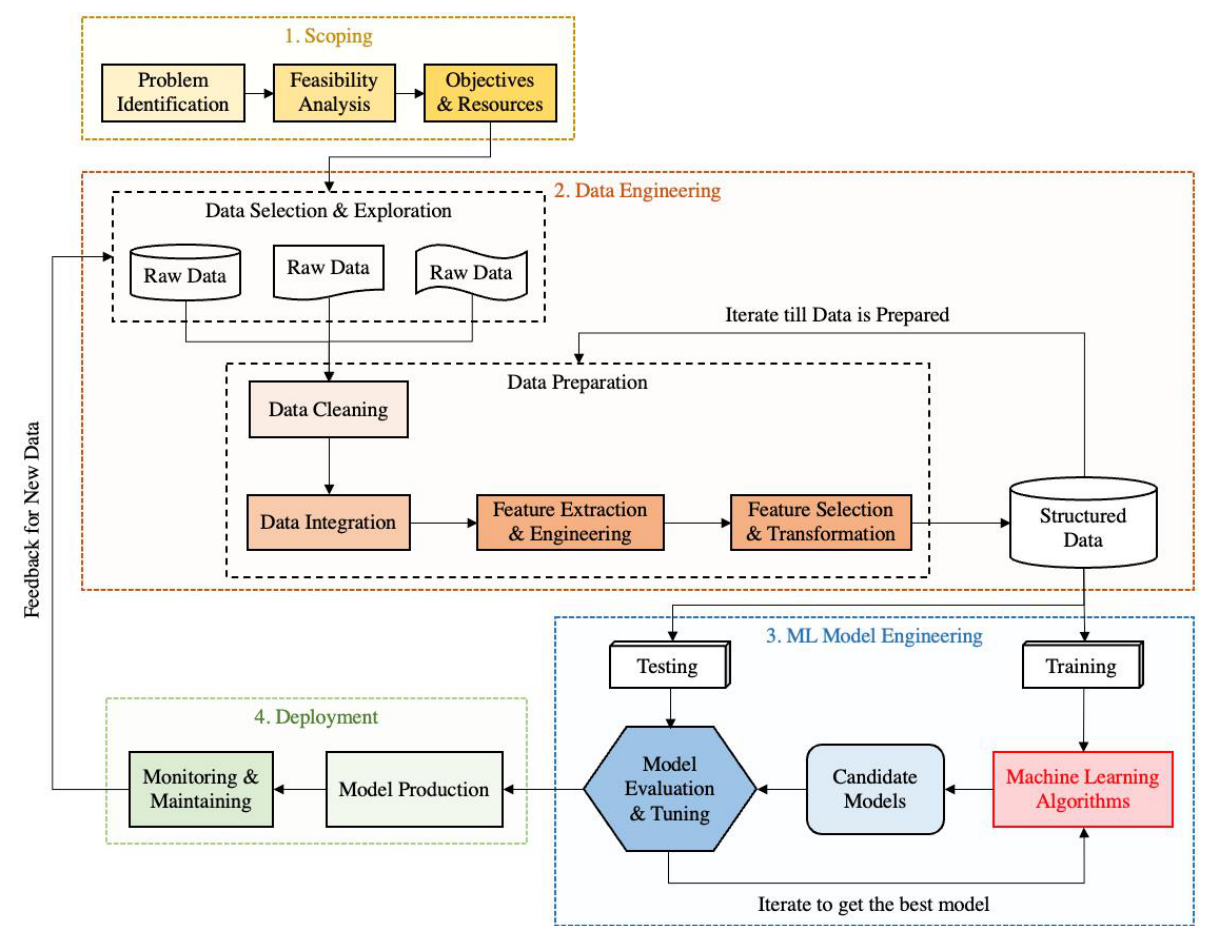
Figure 3. The machine learning engineering